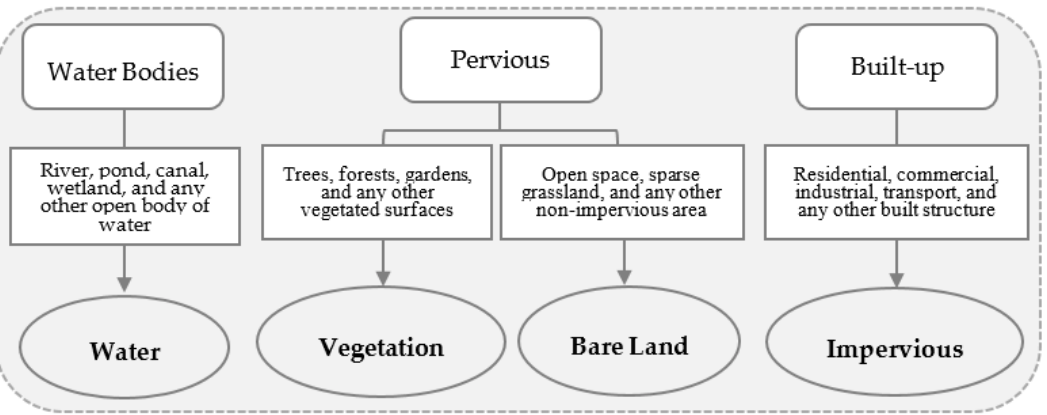
Figure 1. Composition of land cover classes.